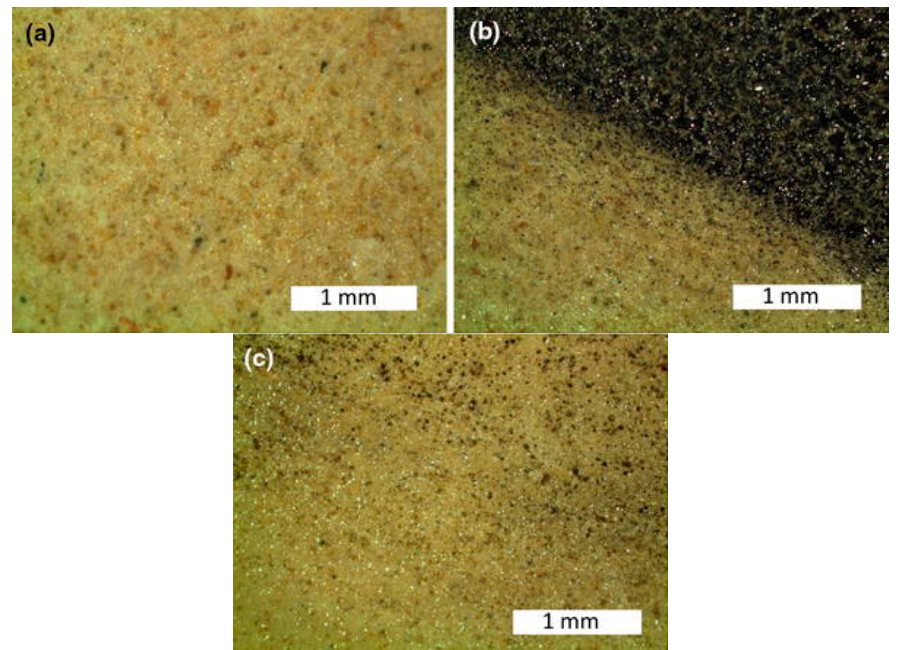
Figure 3. Micro-graphs at reflected light showing Lecce Stone surface: ( a ) after treatment with nano-composite containing 3 wt % of organically modified montmorillonite; ( b ) after staining by spray paint (upper right area in the picture); and ( c ) after 8 consecutive staining/cleaning cycles. Reprinted with permission from [21]. Copyright 2014 Springer.